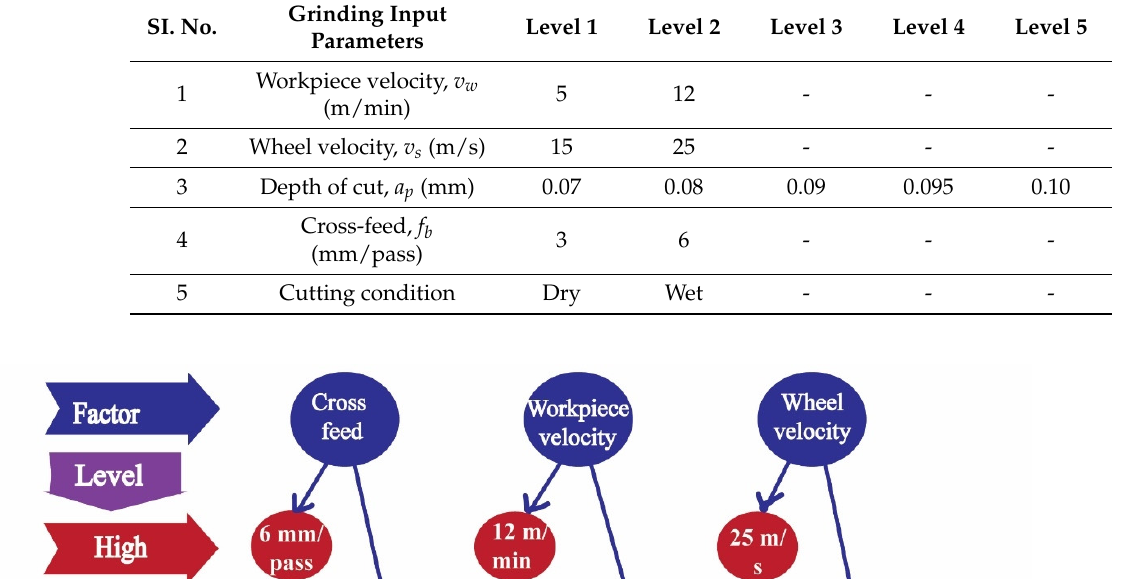
Table 4. Input parameters and their levels.